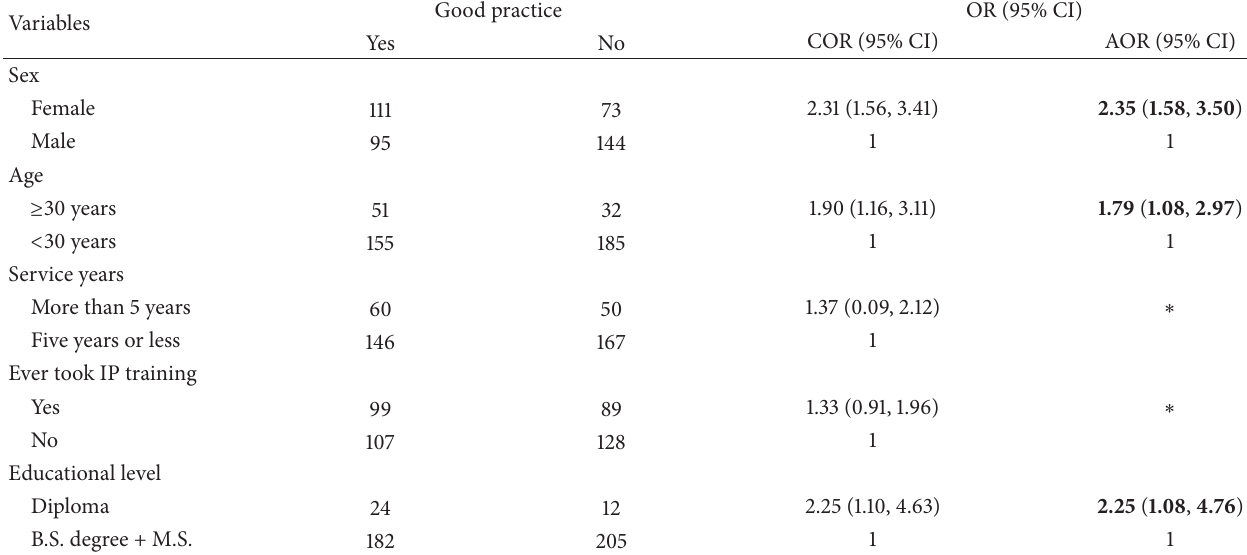
Table 3: Multivariate logistic regression of factors associated with practice of nurses in surgical site infection prevention activities in Gondar and Debre Markos Referral Hospitals, Northwest Ethiopia, 2015 ( 𝑛 = 423